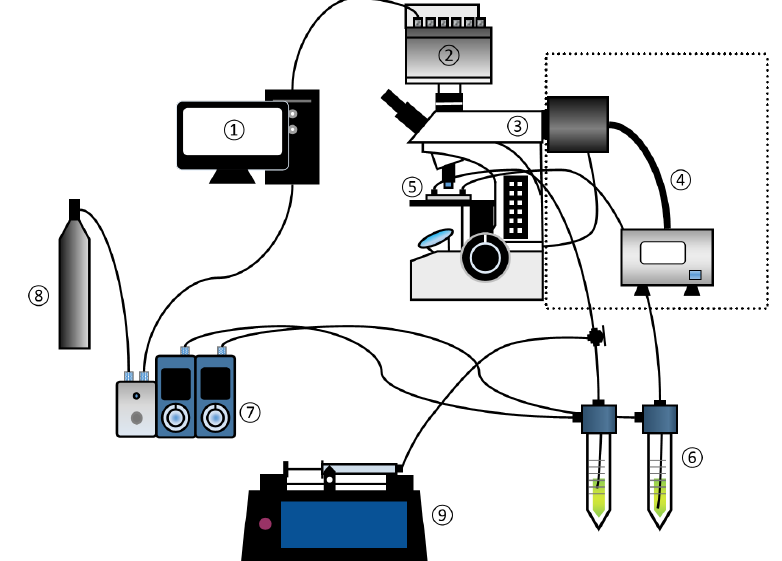
Figure 2. The schematic of this microfluidic study. The labeled components are: 1 Workstation; 2 Phantom VEO 440L High Speed CMOS Monochromatic Camera (Wayne, New Jersey. Wayne, New Jersey); 3 Olympus BX51 TF Microscope (Japan); 4 Olympus Microscope Fluorescence 100W with Mercury Lamp U-LH100HGAPO & Power; 5 Micromodel; 6 Fluigent P-Cap Reservoirs (Paris, France); 7 Fluigent Lineup Link & Lineup Push-Pull Pressure Controller; 8 Nitrogen gas tank; 9 Harvard Apparatus Standard PHD ULTRA CP Syringe Pump (Holliston, Massachusetts, United